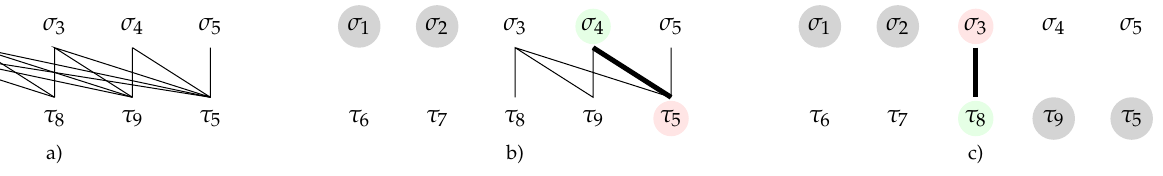
Figure 5. ( a ) The conflict graph of the synchronization problem of Figure 3. The conflict ( σ 2 , τ 7 ) is resolved with the winner τ 7 . ( b ) The conflict graph after resolving ( σ 2 , τ 7 ) ; commands σ 1 and σ 2 are deleted. The next conflict we resolve is ( σ 4 , τ 5 ) . ( c ) The conflict graph after resolving ( σ 4 , τ 5 ) with the winner σ 4 ; commands τ 9 , τ 5 are deleted. The final conflict graph contains the commands σ 4 , σ 5 , τ 6 , τ 7 , τ 8 , and no